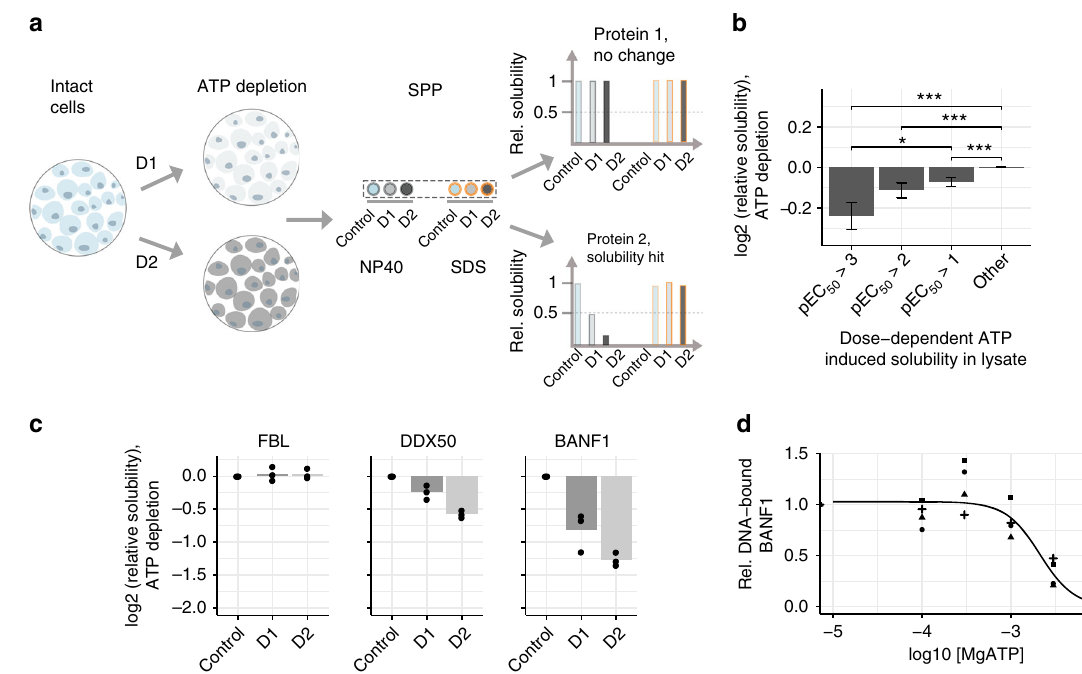
Fig. 4 SPP of ATP-depleted cells recapitulates effects observed in crude lysate. a Experimental setup of SPP in ATP-depleted cells. Cells were depleted of ATP by inhibiting glycolysis and oxidative phosphorylation with two combinations of 2-deoxyglucose (2DG) and Antimycin-A (AA) (D1: 0.1 nM AA and 1 mM 2DG, D2: 1 nM AA and 10 mM 2DG). The untreated cells and the cells from the two ATP-depleted conditions were divided into two aliquots each, of which one was solubilized with NP40 while the other using 1% SDS. All samples were digested with trypsin, labeled with different TMT10 isotope tags and analyzed by LC-MS/MS. b Change in solubility calculated for proteins binned according to their propensity for solubilization with ATP in crude lysate (pEC 50 x -axis), following ATP depletion in cells (from three independt experiments). Error bars represent standard error of the mean. Signi fi cance levels obtained from a Wilcoxon signed-rank test were encoded as * p < 0.05, ** p < 0.01, and *** p < 0.001. c Change in solubility of FBL, DDX50, and BANF1 following ATP depletion in cells, measured by calculating the log 2 ratios of NP40-processed untreated and ATP-depleted conditions. d DNA-binding propensity of BANF1 in the presence of ATP. Recombinantly expressed and puri fi ed BANF1 was incubated with biotinylated double stranded DNA in the presence of increasing concentration of ATP. The DNA-bound fraction of BANF1 was pulled down using streptavidin beads and measured using quantitative mass spectrometry. Rel. DNA-bound fraction of BANF1 was calculated as the ratio protein bound to DNA in the presence of ATP compared to control sample without ATP. Data from four independent trials have been shown. Violin plots represent relative densities. For all box plots, the center line is the median, bounds of the boxes are the 75 and 25% percentiles (i.e., the IQR), and whiskers correspond to the highest or lowest respective value. If the lowest or highest value is an outlier (greater than 1.5*IQR from the bounds of the boxes) whiskers are exactly 1.5*IQR. Numbers above violin plots represent number of proteins. Source data are provided as a Source Data fi le for panels B –